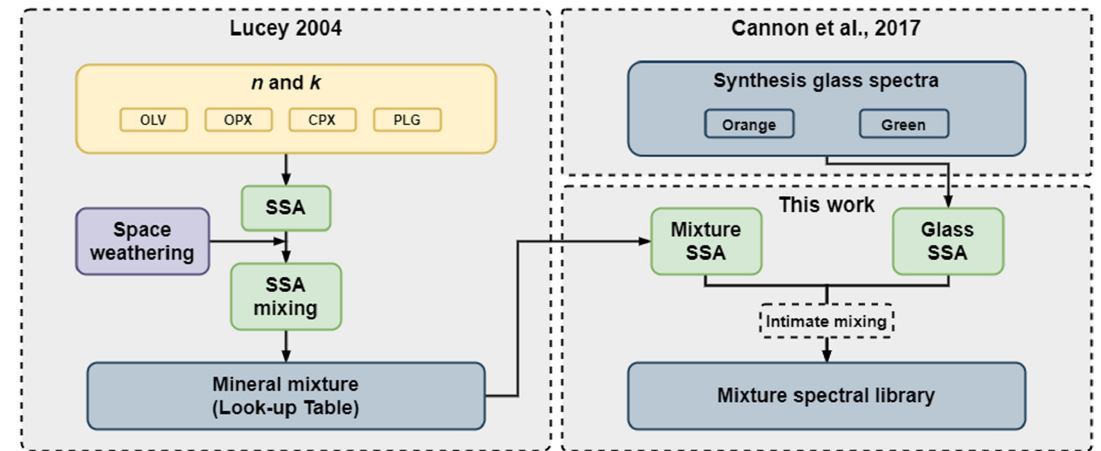
Figure 3. The modeling procedure of constructing the spectral mixing library. We added one of the synthetic glasses, the orange glass or the green glass, to the library [19,34]. The effective grain size of the minerals in the mixture is fixed at 17 μ m, which is a representative value of lunar soil based on the LSCC research [1,13]. Due to laboratory Glass varied from 0 to 80 wt.%, and minerals OLV, OPX, CPX, and PLG varied preparation procedures, the synthetic glass grains are smaller than 53 μ m. Compared with other glass samples, the particle size distribution of Cannon’s synthetic samples is smaller [19] and is closer to the particle size of the lunar regolith. The Mg number is fixed at 65 [34] because the LSCC data has Mg numbers between 50–70. To simulate the reddening and darkening effects caused by space weathering, nanophase irons with weight percent ‐ ages from 0.0005 wt.% to 0.007 wt.% were added to all library spectra [34]. It should be noted that the synthetic green/orange glass in the MSL differs from the matured lunar glass in that the latter contains a large amount of glass ‐ welded aggregates (~30–50% modal abundance of the LSCC soil). The agglutinate glasses also originated from volcanic and impact processes. Because of the nanophase iron inside the agglutinates [25,36], the ab ‐ sorption of agglutinate has been largely smoothed out, as shown in Figure 2a, and the modification effect of the agglutinate on the spectrum of the lunar regolith is lower than that of volcanic glass. The spectral reddening and darkening due to space weathering is also considered by adding nanophase iron with varying content from 0.0005 wt.% to 0.007 wt.% to the mineral mixture when constructing the MSL (Figure 3). Thus, in this work, we only discuss the simple case of adding volcanic glass as the glass endmember.